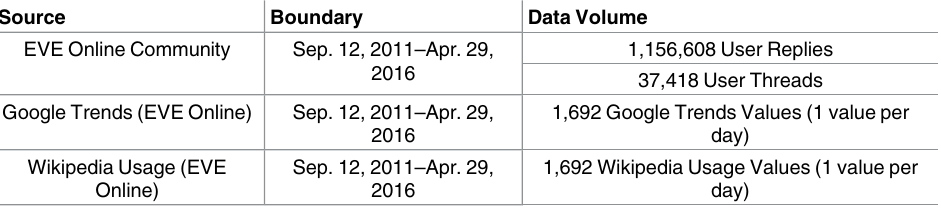
Table 1. Summary of crawled data